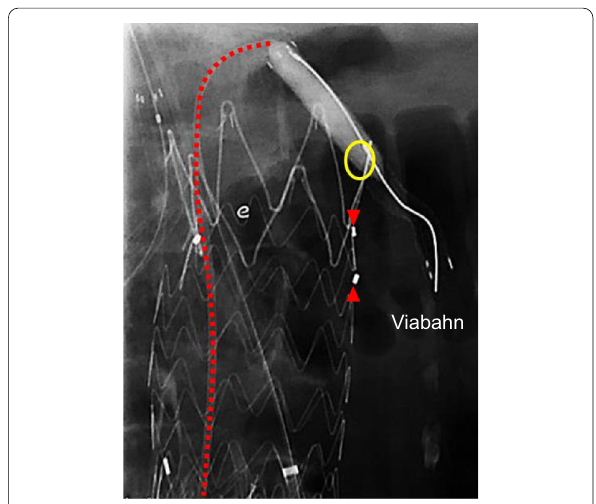
Fig. 3 The angioplasty balloon was inflated in the proximal end of the Viabahn endoporosis and pushed up for replacing the proximal end from downward to upward. The ring maker indicates the orifice of the left renal artery and the arrowhead indicates the fenestration to the left renal artery. The ring maker indicates the orifice of left renal artery